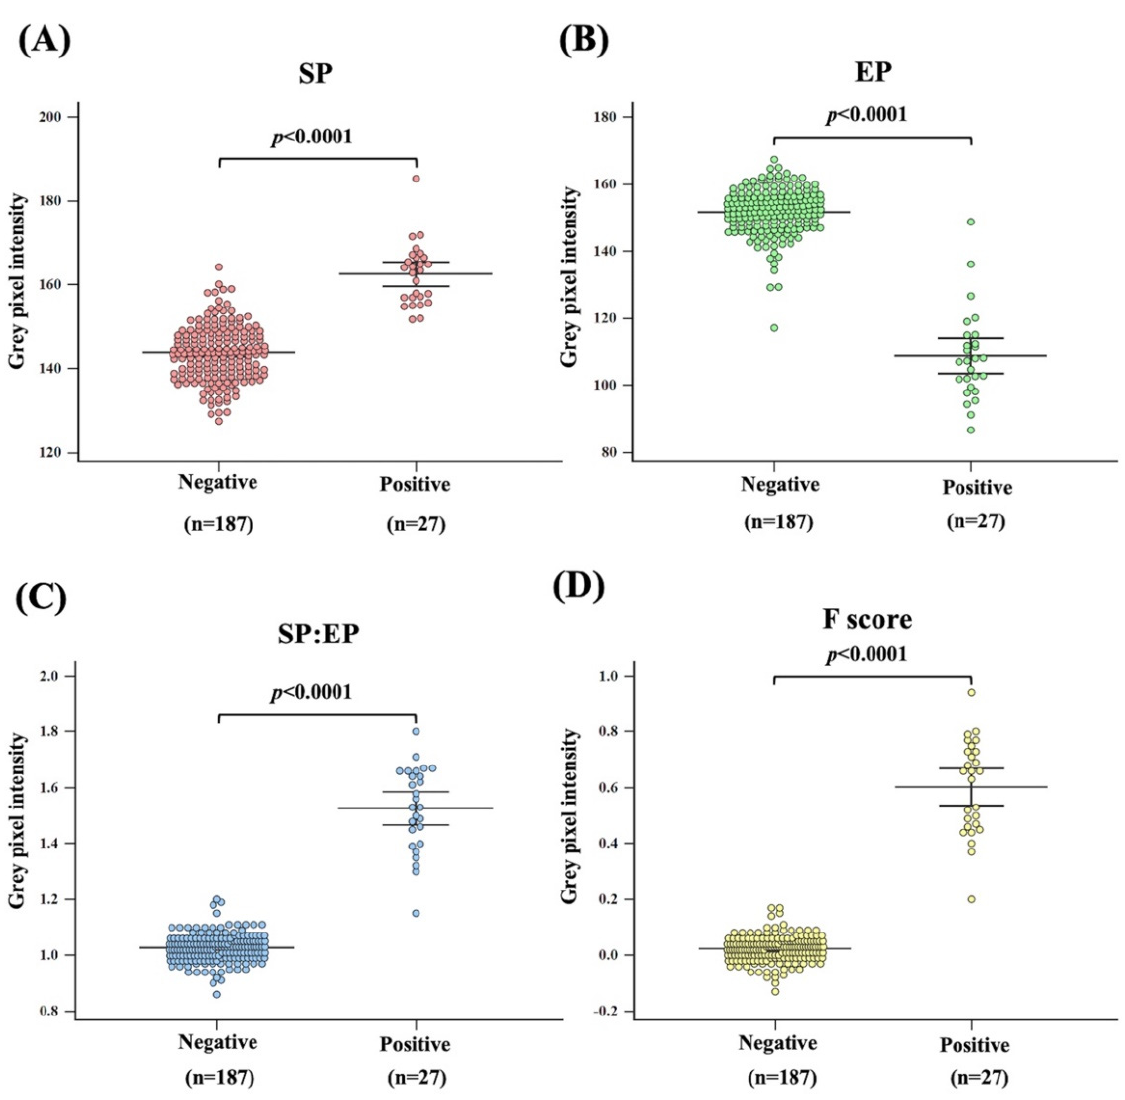
Figure 3. Comparison of grey pixel intensity between Mi a negative and Mi a positive using Mann– Whitney tests. ( p -value < 0.05 as statistically significant.). Grey pixel intensity in different analysis criteria observed by ( A ) SP; ( B ) EP; ( C ) SP:EP ratio and ( D ) F score. We performed ROC curve analysis using MedCalc to set the cut-off. The SP pixel intensity revealed AUC = 0.980 ( p < 0.0001: 95%CI = 0.951–0.994) (Figure 4A), and the optimal criterion was more than 160.17, which gave 62.96% sensitivity, 100% specificity, and 96.41% accuracy (Table 1). Likewise, the pixel intensity from EP showed AUC = 0.988 ( p < 0.0001: 95%CI = 0.962–0.998) (Figure 4B), and the optimal criterion was less than or equal to 126.73, which gave 96.30% sensitivity and 100% specificity (Table 1). We observed 100% sensitivity, specificity, and accuracy (Table 1) when we applied the SP: EP ratio and F-score ( p < 0.0001: 95%CI = 0.983–1.000) (Figures 4C and 4D, respectively) with the optimal criterion (1.07 and 0.17 for SP: EP ratio and F-score,